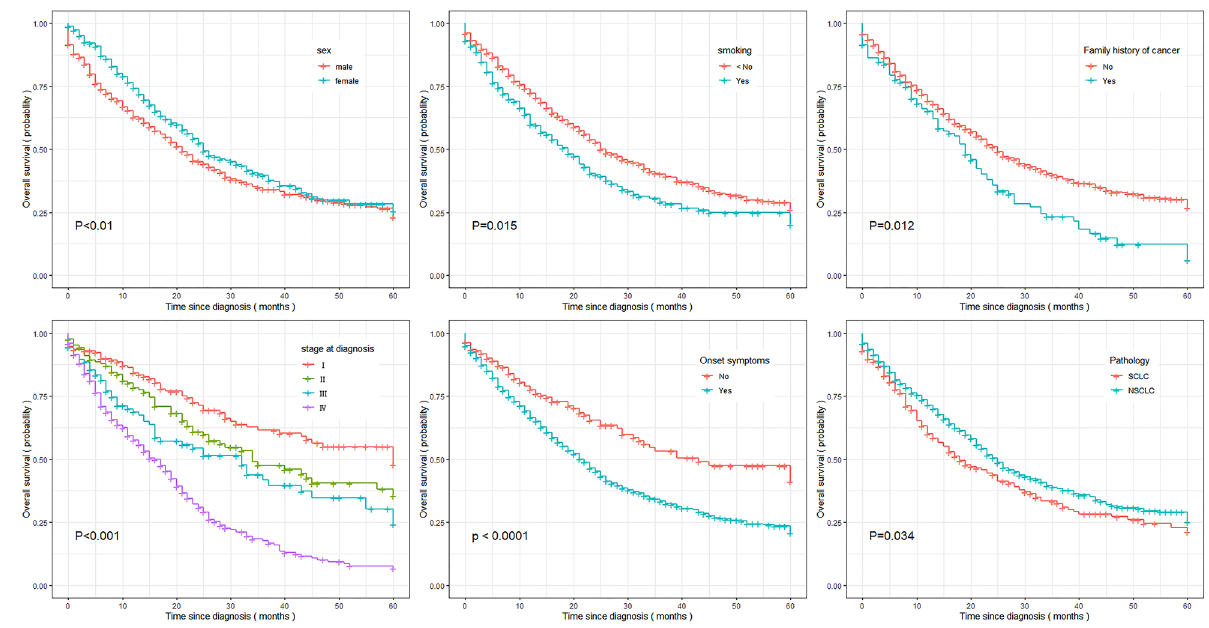
Figure 2. Estimate of five-year relative survival time for the young lung cancer